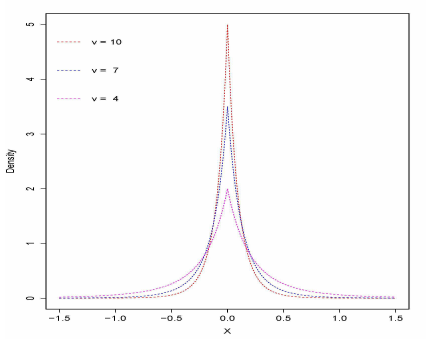
Figure 1 –: Three GDL densities with identical location and scale parameters (m and s) but different shape parameters